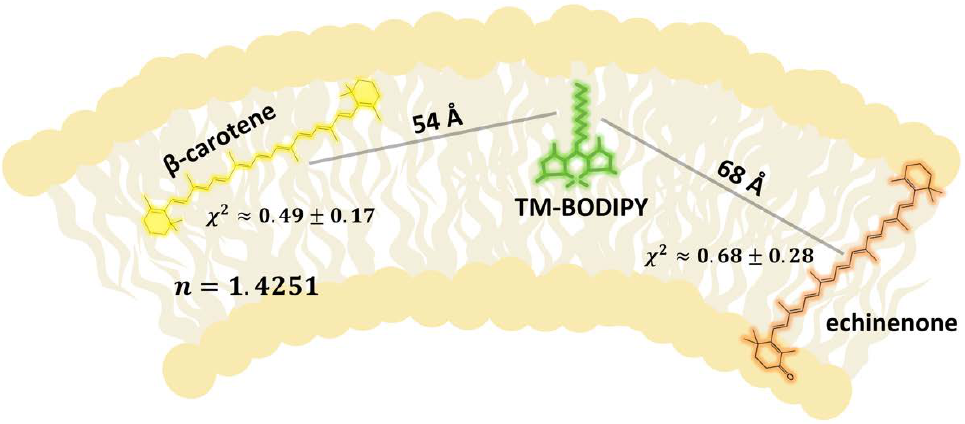
Figure 8. Graphical illustration of the localization of TM-BODIPY, β -carotene and echinenone in the phospholipid membrane. Indicated average orientation factor ( χ 2 ) corresponds to the mutual position of carotenoid and fluorescent probe in the membrane according to molecular dynamics simulations. Average distances between molecules were calculated based on FRET efficiency assessed in the experiment and calculated value of Förster distances. n is a refractive index which corresponds to soy lecithin emulsion environment.